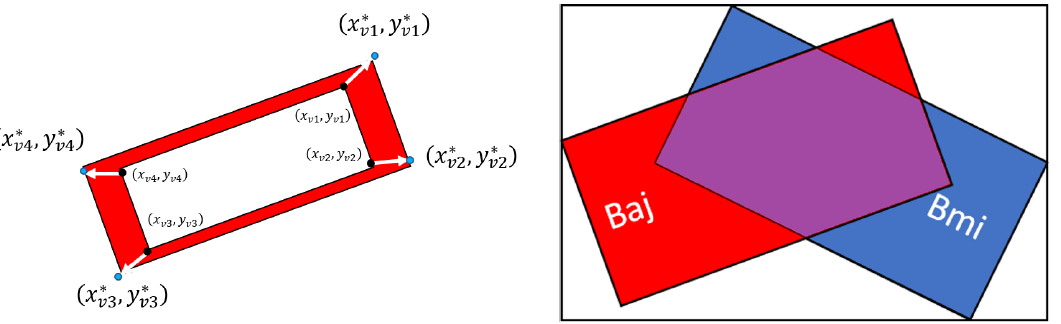
Figure 3. Left panel: representation of vertex projection from original coordinates ( x v , i , y v , i ) to extended coordinates ( x ∗ , y ∗ ). Right panel: illustration of how the intersection between cardiomyocytes (CMs) in v , i v , i the manual and automatic masks was computed. The red box B a CM in the automatic mask M a , whereas the blue box B m manual mask M m . The purple area is the intersection between the areas of the two rectangles: A a